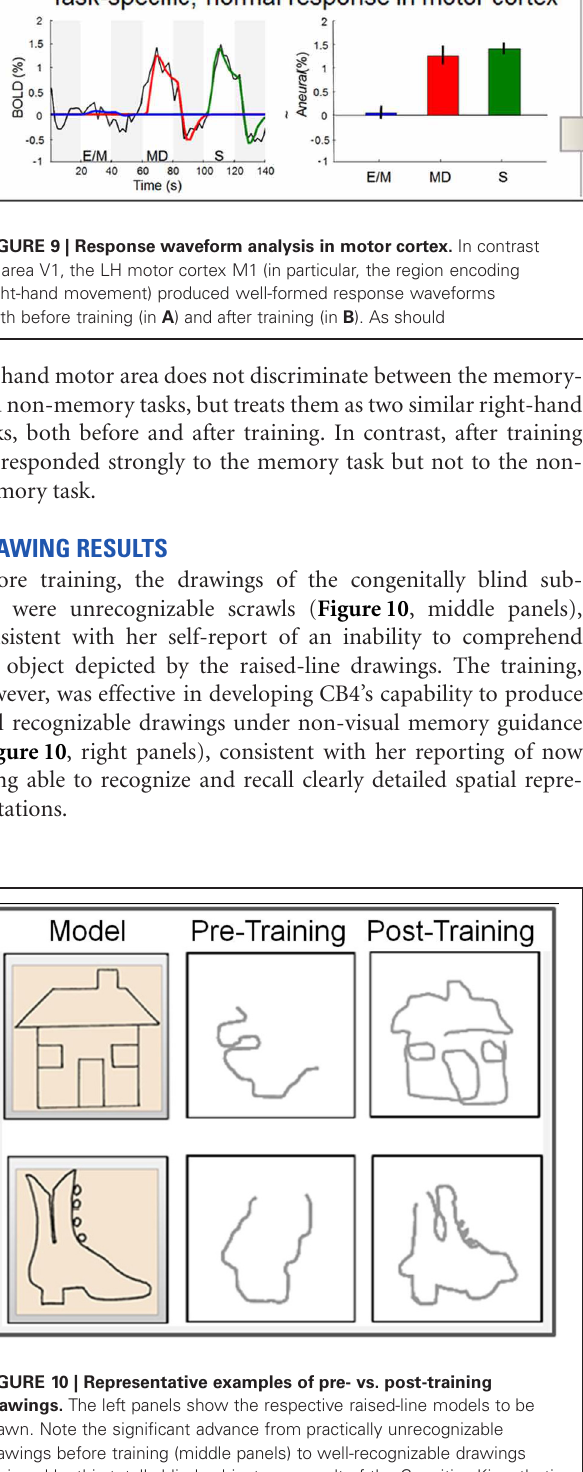
be expected, these responses were strong and positive for the two right-hand tasks ( MD and S ), and zero to negative for the left-hand task ( E/M ). Statistics as in Figure 7 , and Materials and Methods.